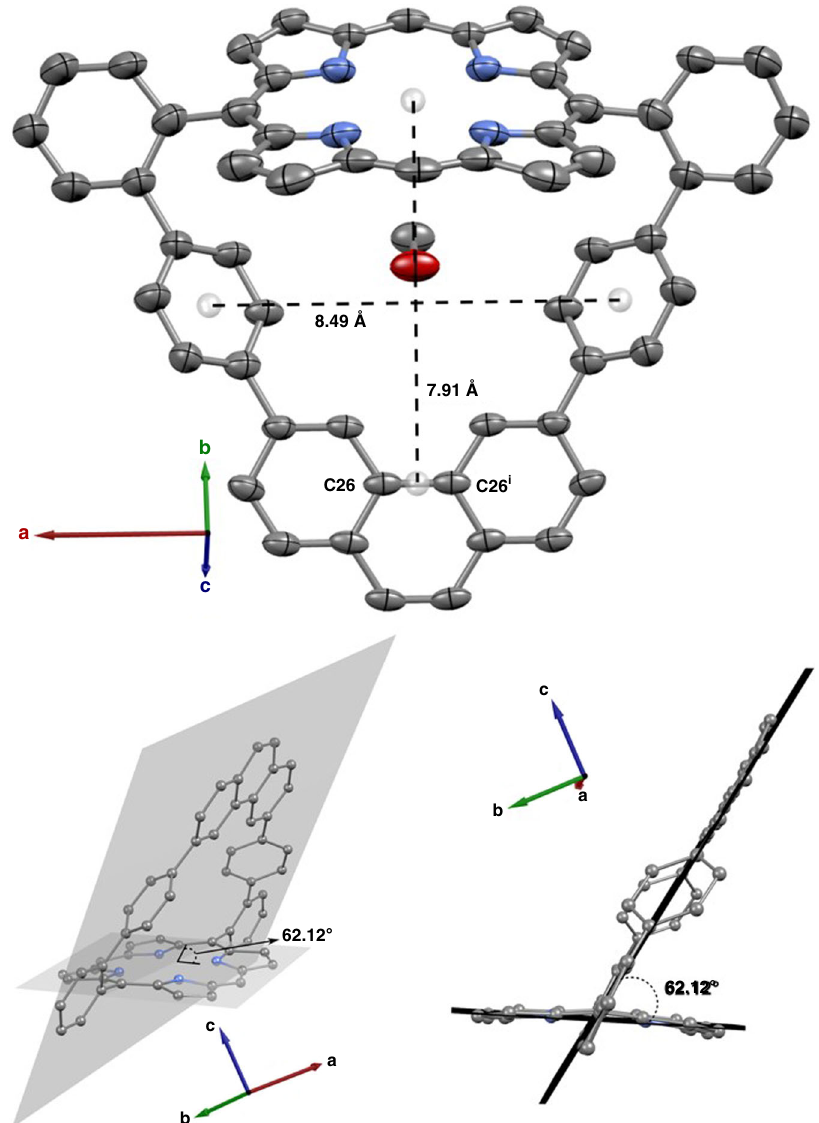
Fig. 2 Representation of the crystal structure of macrocycle 7. Single crystals were grown from a dichloromethane/methanol/tetrahydrofuran saturated solution by slow evaporation. Carbon atoms are shown in gray, nitrogen in blue and oxygen in red. Hydrogen atoms are omitted for clarity purposes. Ellipsoids are drawn at 50% probability levels. Symmetry code: i = 1/2-x, y, z. See Supplementary Fig. S1 for complete atom numbering. CCDC ID